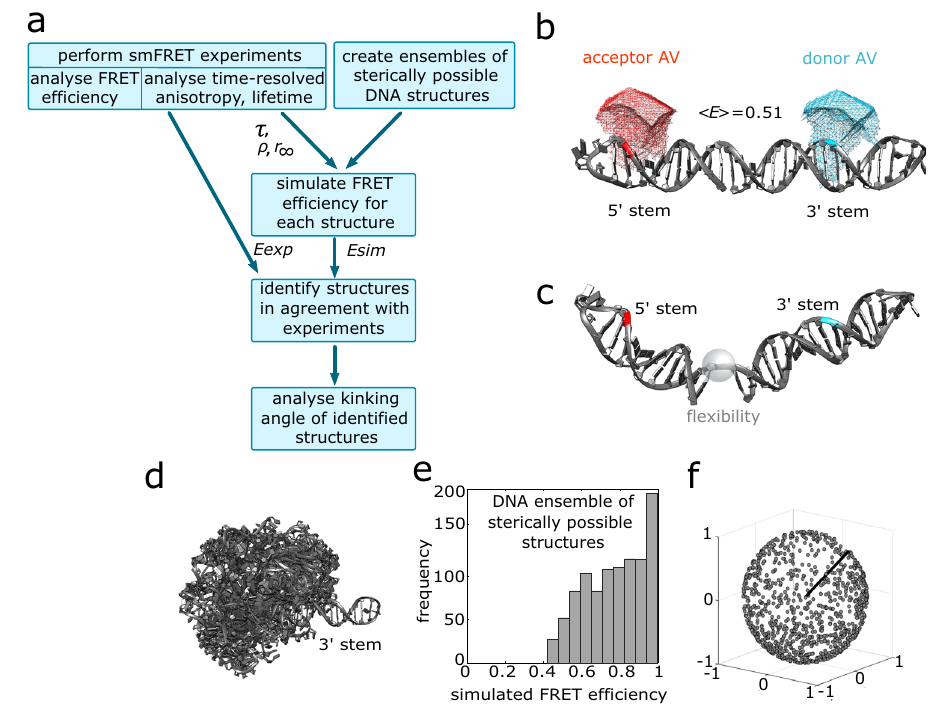
Fig. 3 | Structural analysis of DNA conformation using a computational approach. a Work fl ow for determining the kinking angles of DNA bound to dif- ferent PARP-1 fragments. For an ensemble of possible DNA conformations, the expected FRET ef fi ciencies are simulated, taking experimental data into account, i.e. Förser radius, fl uorescence lifetime and time-resolved anisotropy. From the ensemble of conformations, structures are selected for which the simulated FRET ef fi ciency is in agreement with the measured ef fi ciency within the given uncer- tainties. E exp : experimental FRET ef fi ciency; E sim : simulated FRET ef fi ciency; τ : life- time; ρ : rotational correlation time; r ∞ : residual anisotropy. b Model structure for thestraightDNAligandmodeledinB-form.Thebasestowhichdonorandacceptor are attached are highlighted in cyan and red, respectively. The corresponding computed accessible volumes (AV) are shown by meshes in the respective colors. c Example of a structure taken from the computed ensemble of sterically possible